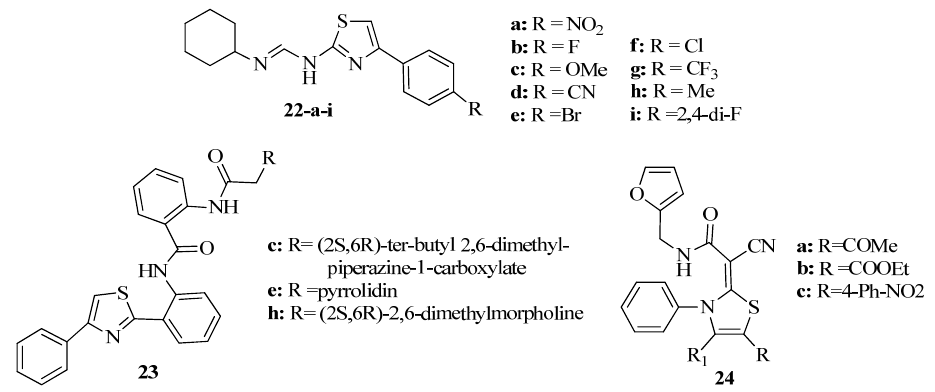
Figure 10. Structures of (E)-N’-cyclohexyl-N-(4-(p-alkyl) thiazol-2-yl) formimidamide and thiazole acetamides ( 22 ) and (E)-2-cyano-2-(4,5-dialkyl-3-phenylthiazol-2(3H)-ylidene)-N-(furan-2-ylmethyl) acetamide (24).